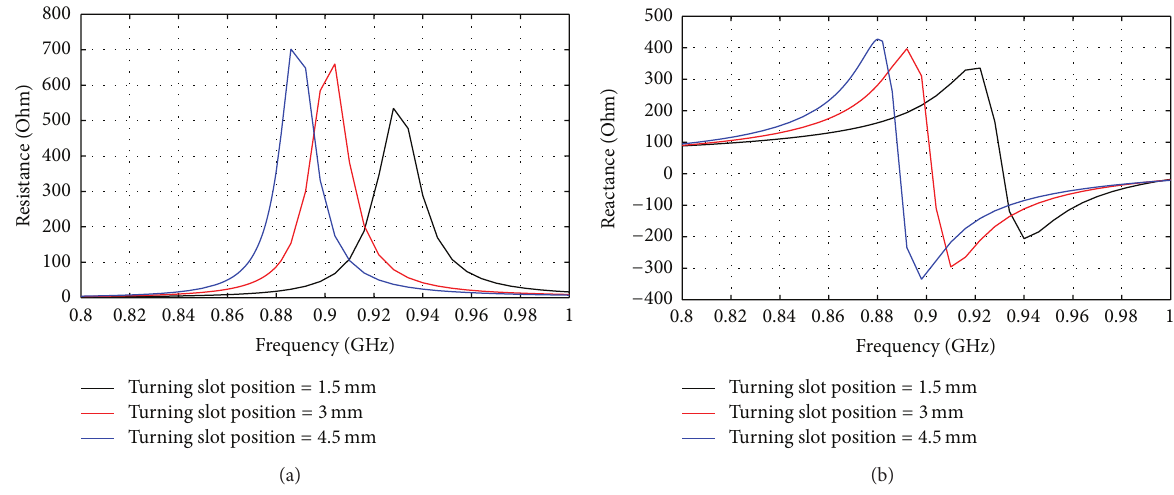
Figure 14: Tuning the real and imaginary parts of the input impedance by changing the distance of the tuning slot from the coupling gap.